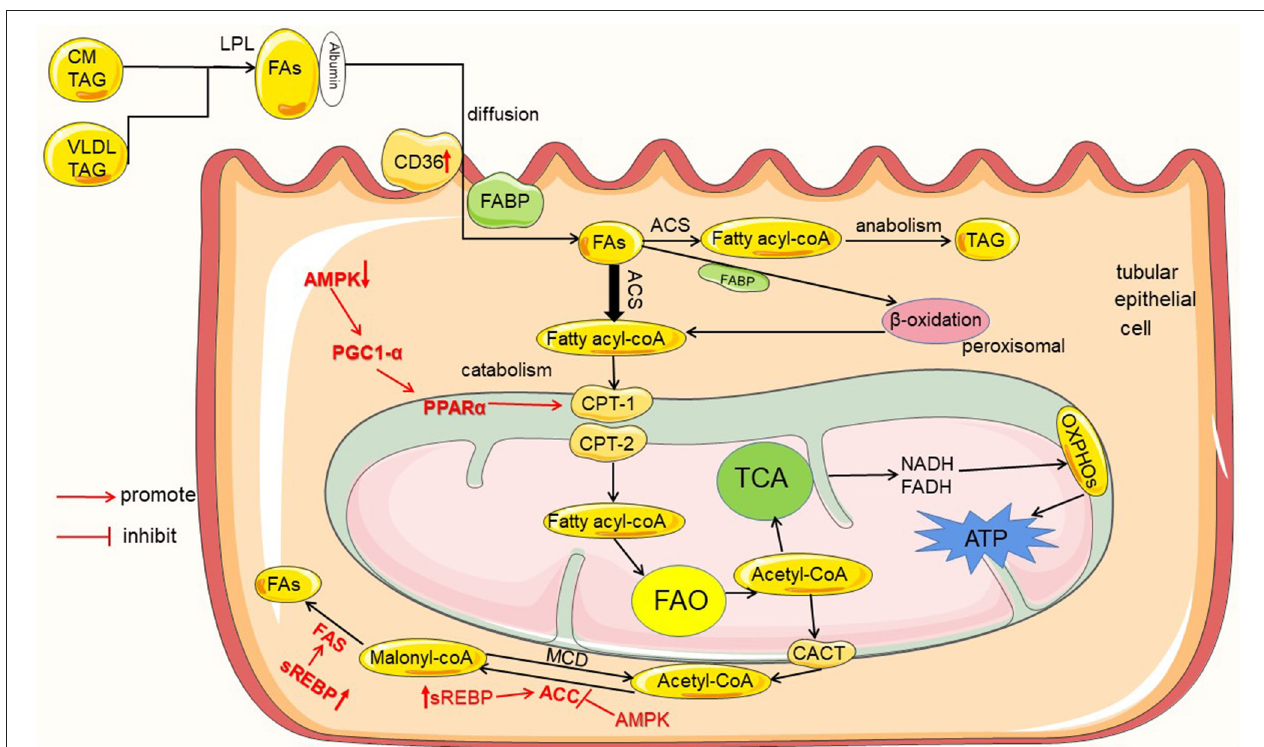
FIGURE 1 | Lipid metabolism in renal tubules and the regulation mechanism in diabetes mellitus. Tubules mainly utilize the metabolism of FAs as an energy source, and the metabolism of FAs includes catabolism and anabolism. FAs entering the renal tubules mainly come from the blood circulation. Initially, FAs are esterified in the form of VLDL and CM-TAG; then, esterified FAs are catabolized by LPL to release FAs. Extracellular FAs enter the cell by autonomous diffusion or transporters as CD36 and FABP. FAs into the cell are activated by ACS to fatty acyl-CoA, and then part of fatty acyl-CoA enters the mitochondria via CPT-1 and CPT-2 for catabolism to produce acetyl-CoA, which enters TCA to produce ATP required by the kidney; and excess fatty acyl-CoA enters the anabolic pathway to generate TAG. In addition, the product of FAO acetyl-CoA can also be transported out of mitochondria by CACT and converted to malonyl-CoA by ACC, and malonyl-CoA resynthesizes new FAs by FAS. In diabetes and high glucose conditions, the proteins are high- or down regulated in the uptake, metabolism and synthesis of FAs, which are marked in red